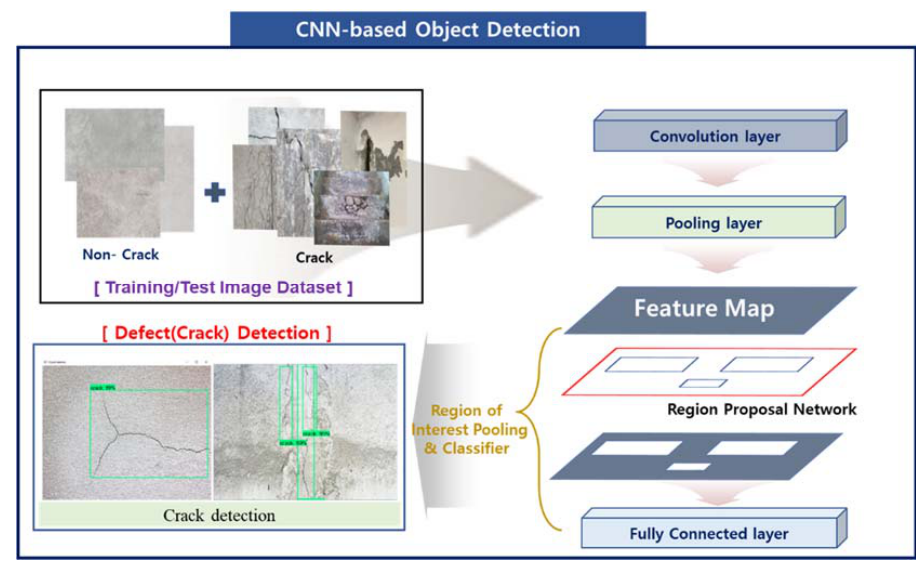
Figure 7. CNN ‐ based image training and defect detection process.